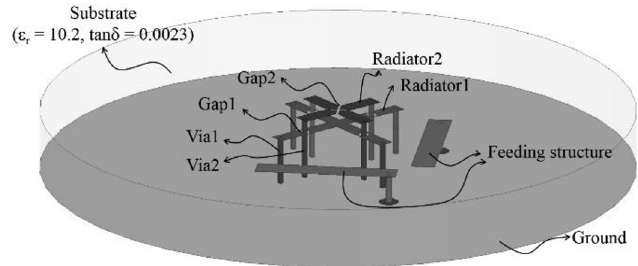
Fig. 14. Structure of the proposed CP MZR antenna.